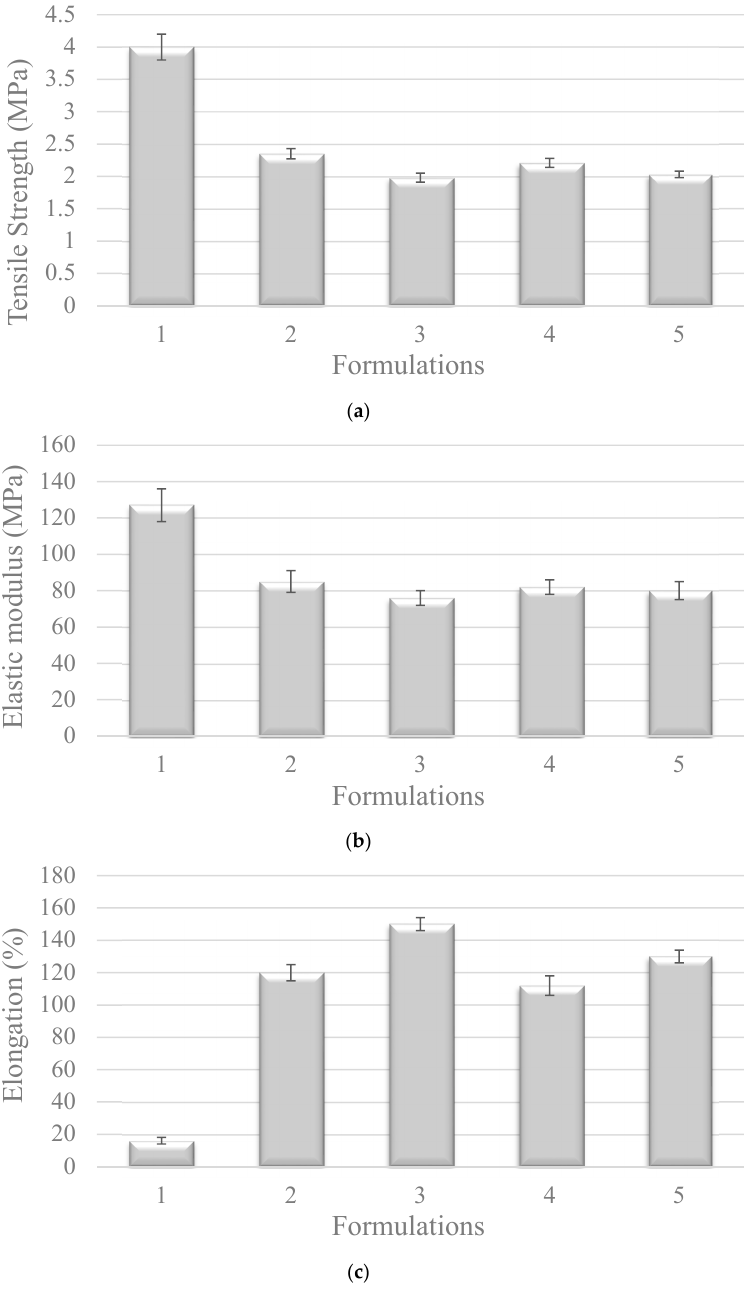
Figure 1. Mean values and standard deviation of the tensile strength ( a ), elastic modulus ( b ), and elongation at a breakpoint ( c ) for the different films stored for one week at 53% RH and 25 ° C. The formulations: 1 (without essential oil), 2 (essential oil of lime), 3 (essential oil of fennel), 4 (essential oil of lavender), 5 (essential oil of lime, fennel and lavender).